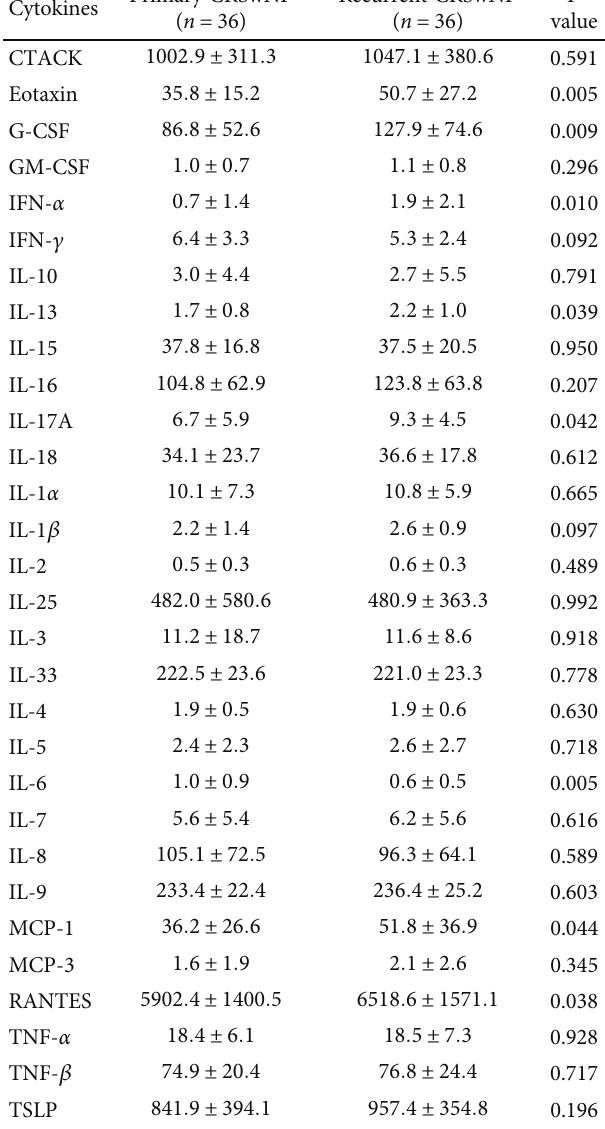
Table 1: The demographic and clinical variables between the two groups.